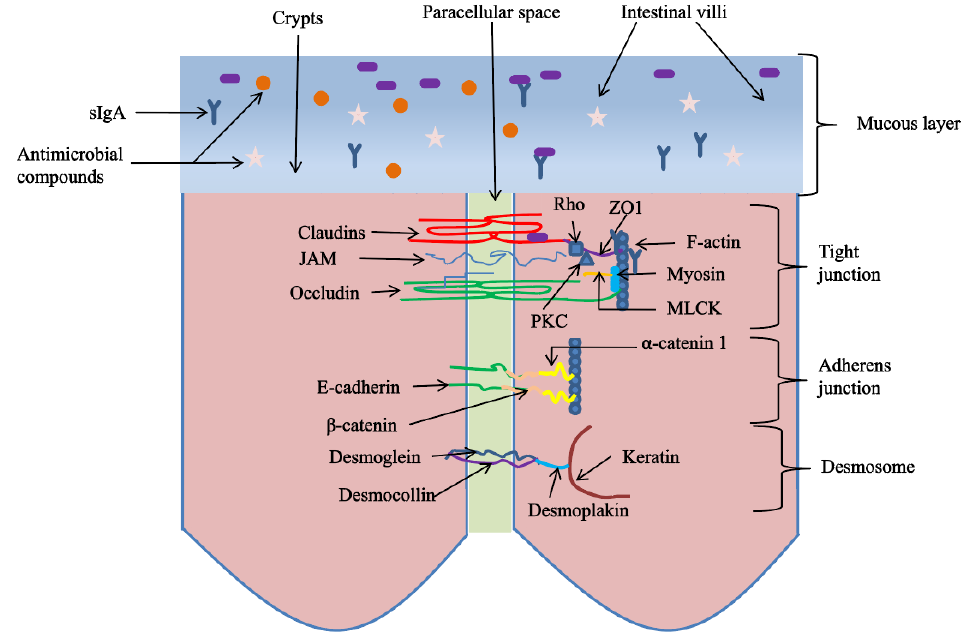
Figure 2. Schematic diagram of intestinal epithelial intercellular junction complex and intestinal mucosal layer [67] Reprinted with permission from Ref. [67]., Patra. (2020). mucosal layer [67] Reprinted with permission from Ref. [67], Patra.